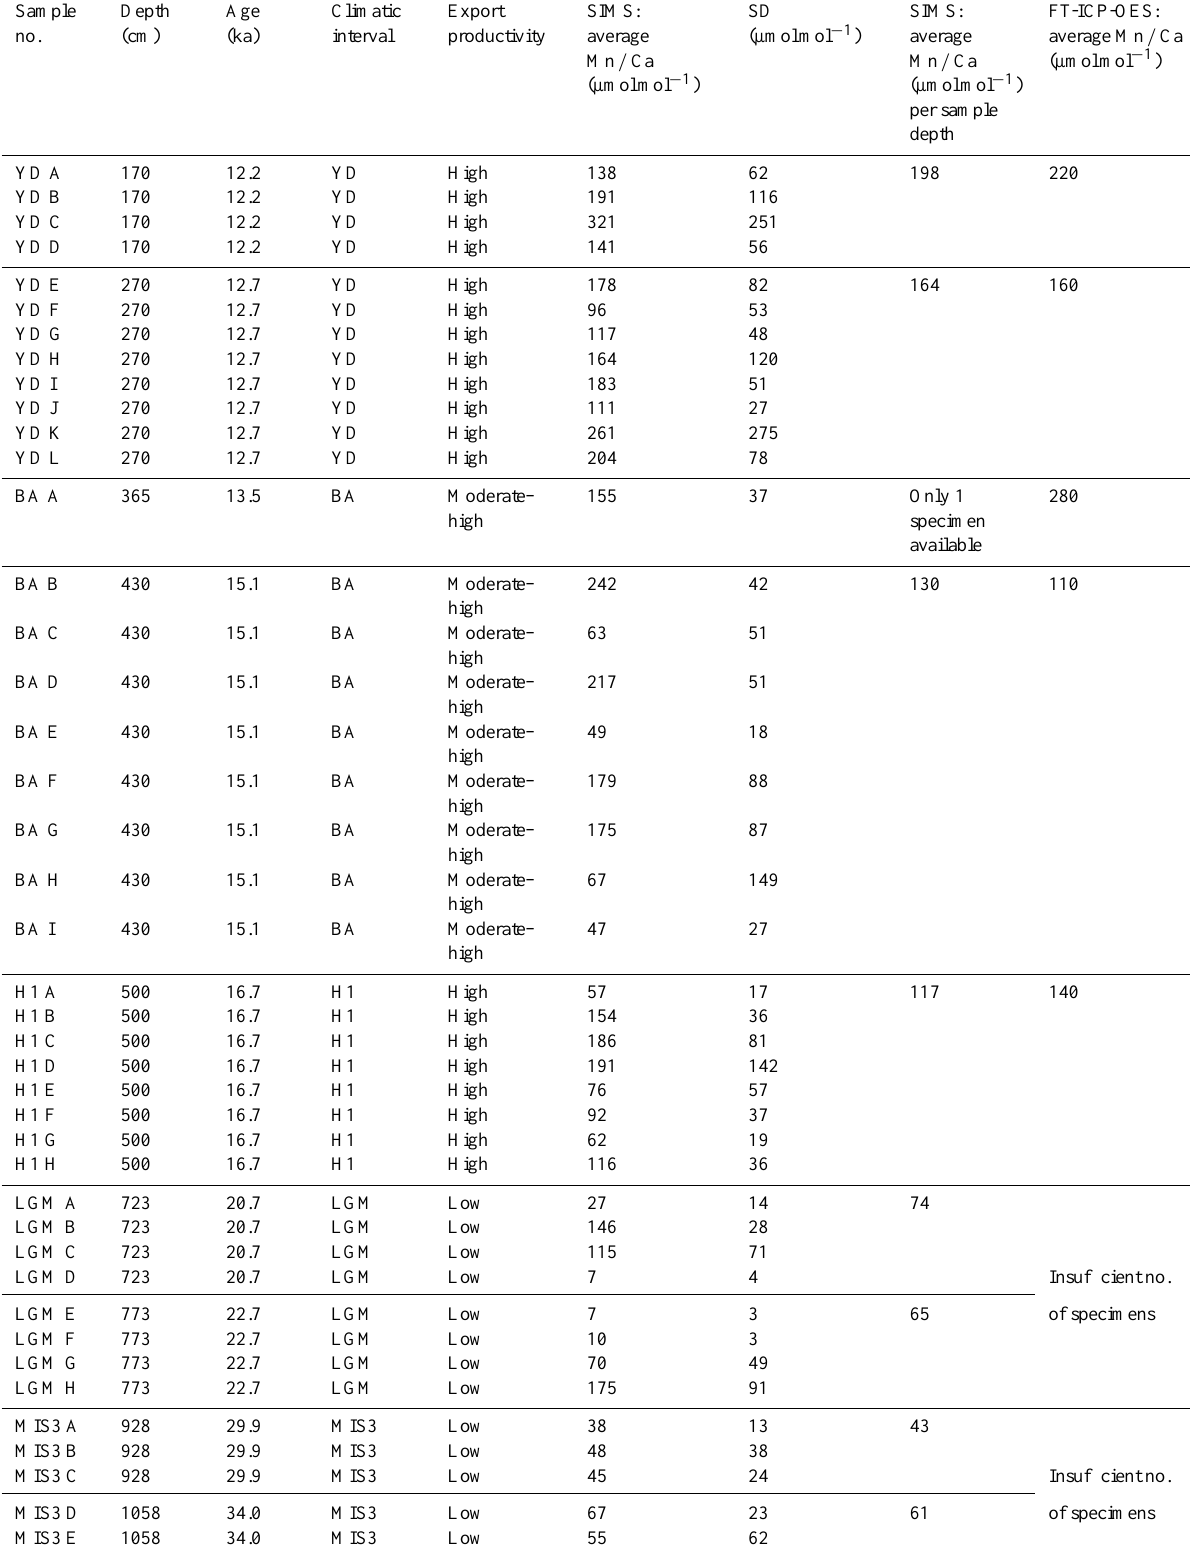
Table 1. Sample list: climatic intervals, export productivity according to diatom export, average foraminiferal Mn / Ca for different samples determined by SIMS and FT-ICP-OES. Sample